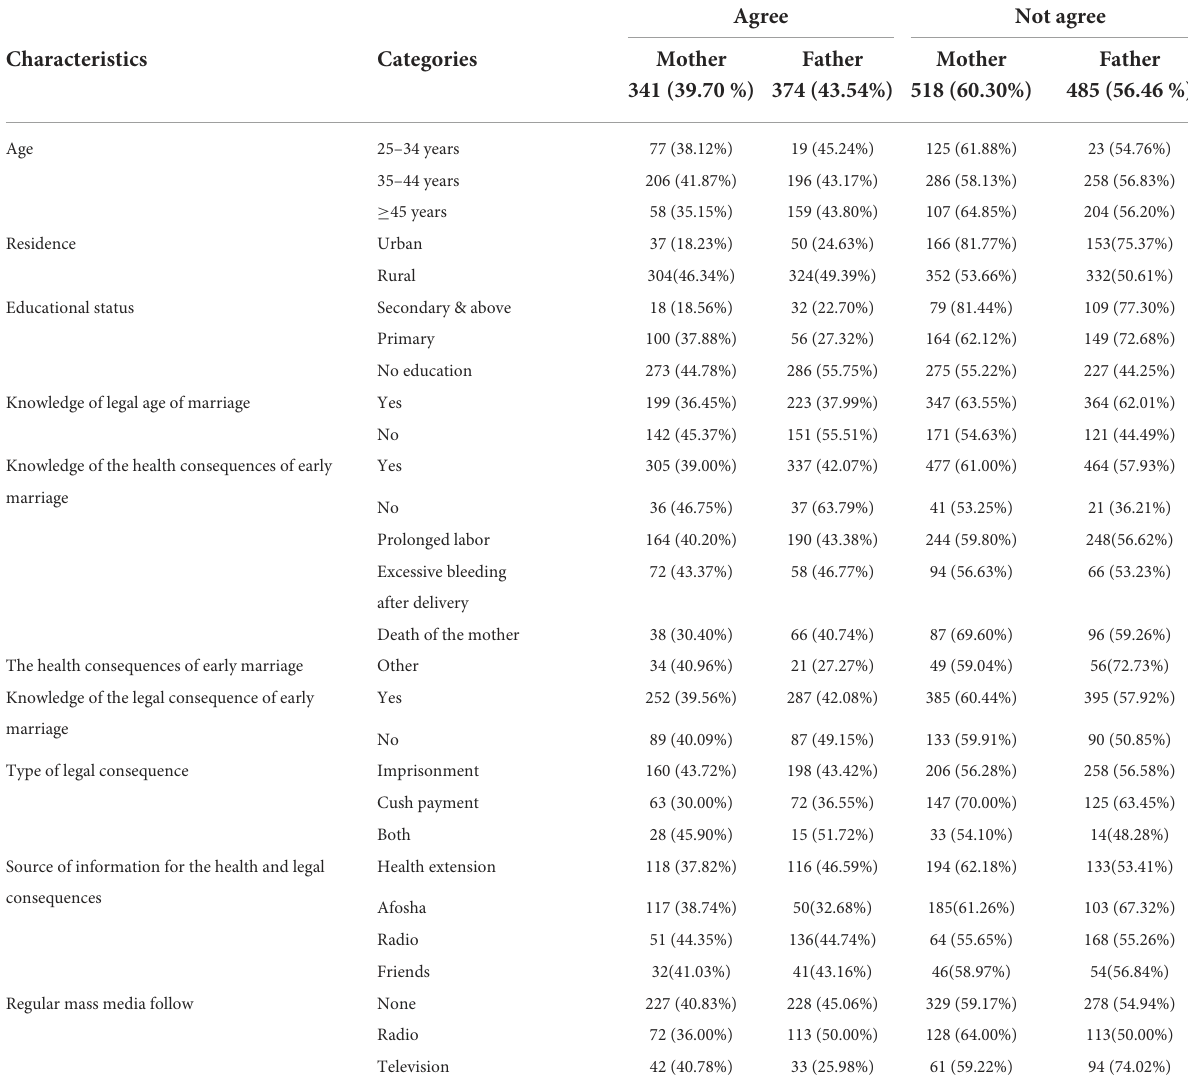
TABLE 2 Background characteristics of parents with their early marriage intention in Kersa HDSS, Eastern Ethiopia,